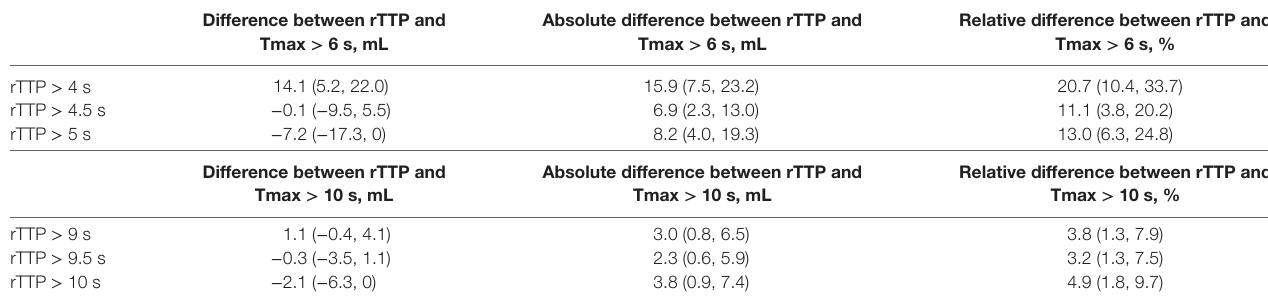
TaBle 2 | Comparison of rTTP and Tmax lesion volumes for different rTTP